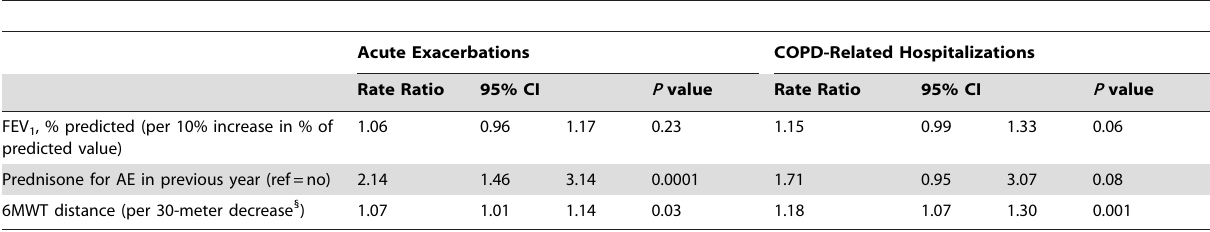
Table 4. Multivariate Model of Associations between 6MWT distance and Number of Acute Exacerbations and COPD-Related Hospitalizations Adjusting for FEV 1 % Predicted and Prednisone for AE in Previous Year. *